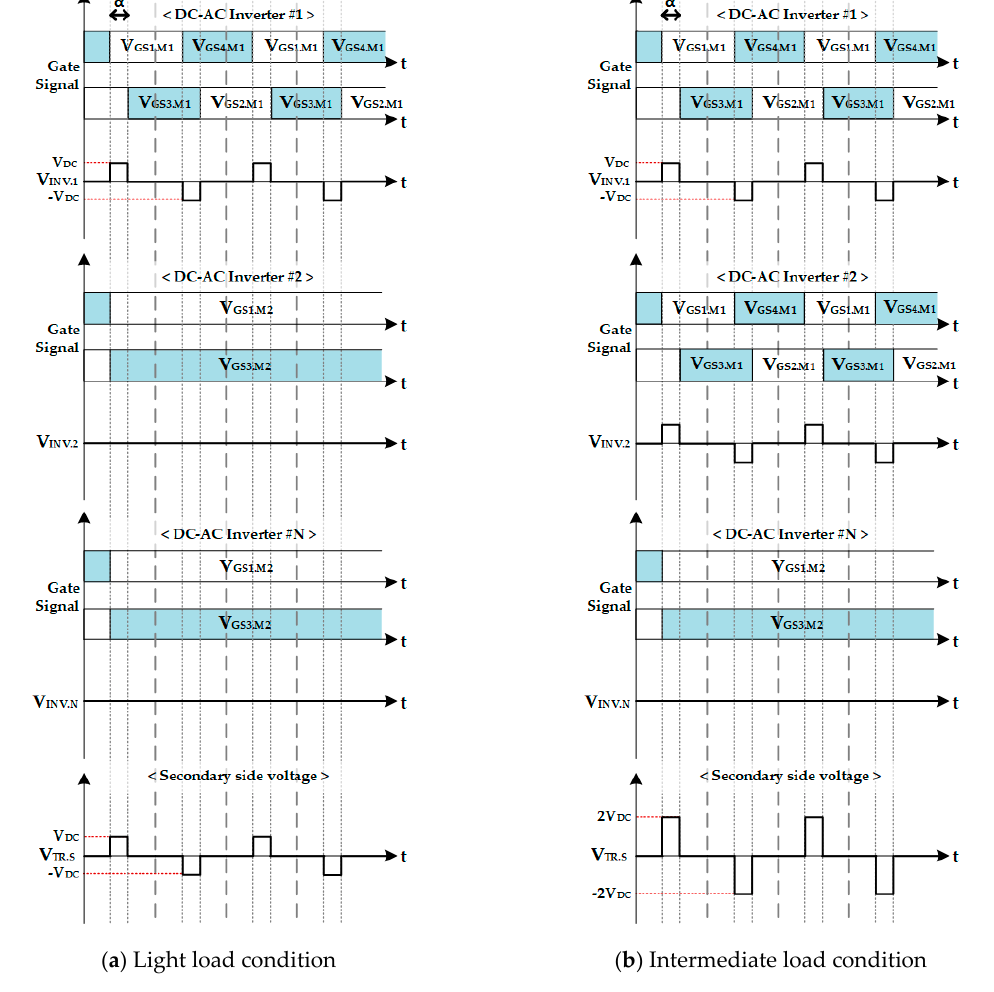
Figure 5. Example waveforms of DC-AC inverters with the proposed control method.